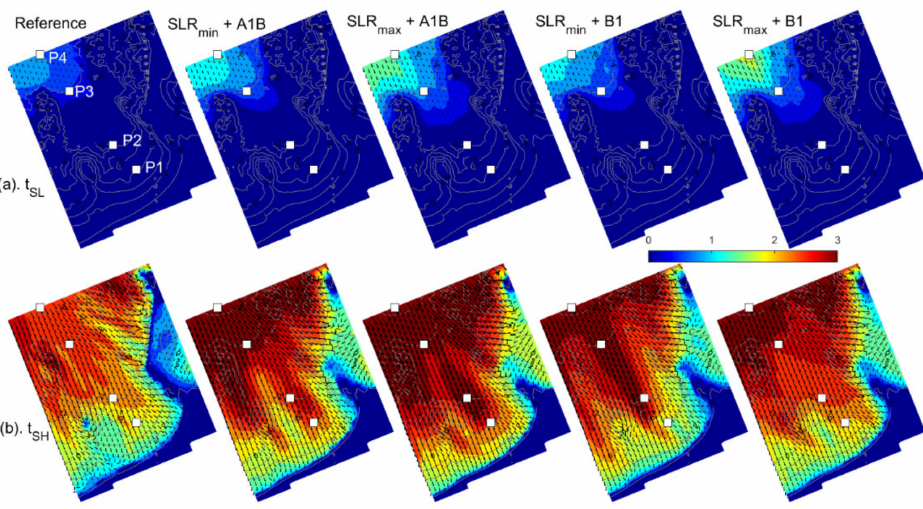
Figure 10. Simulated wave height distributions in the G3 domain for the reference, SLR min + A1B, SLR max + A1B, SLR min + B1, and SLR max + B1 scenarios at t SL : spring-low water ( a ) and t SH : spring- high water ( b ), indicating the analysis locations (white squares) P1 (0 m depth), P2 (2 m), P3 (4 m), and P4 (6.5